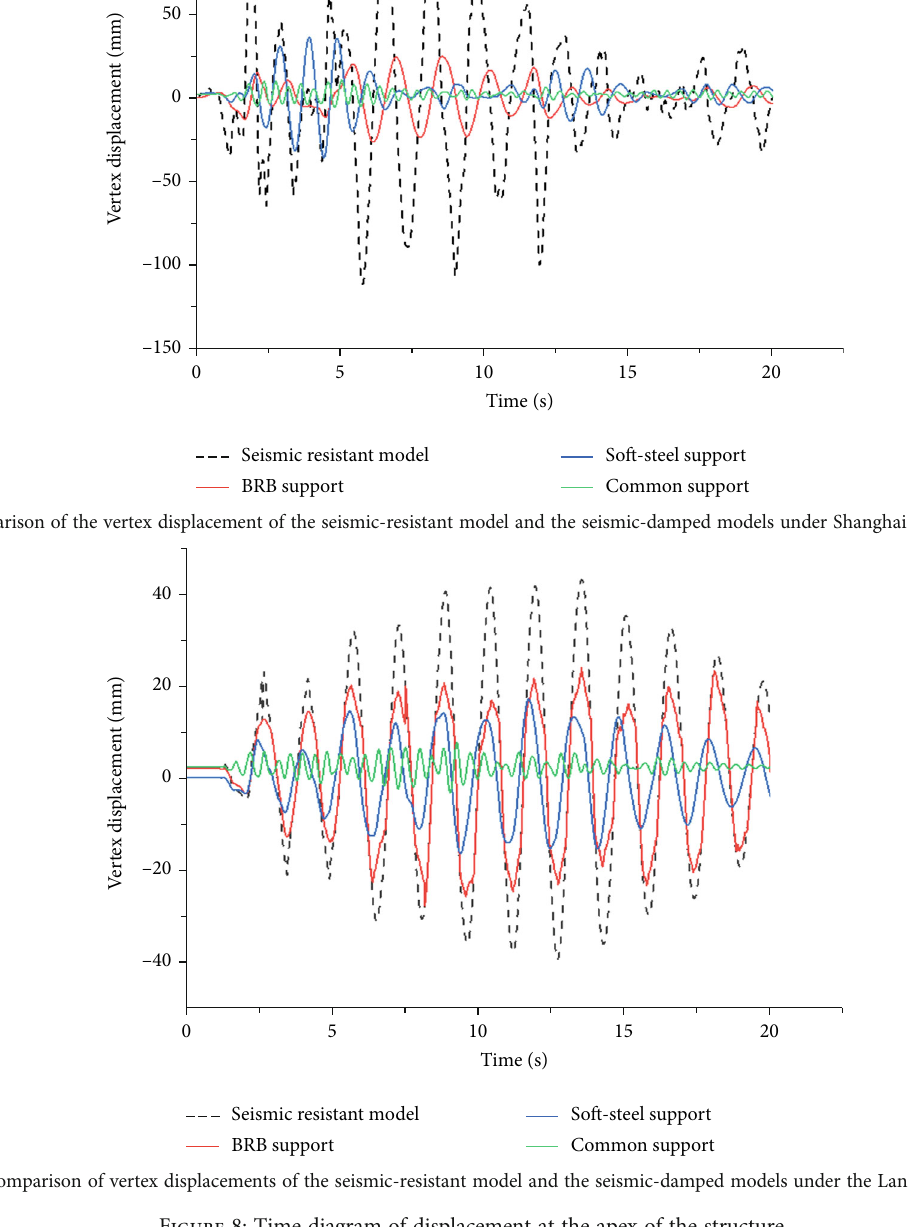
Figure 8: Time diagram of displacement at the apex of the